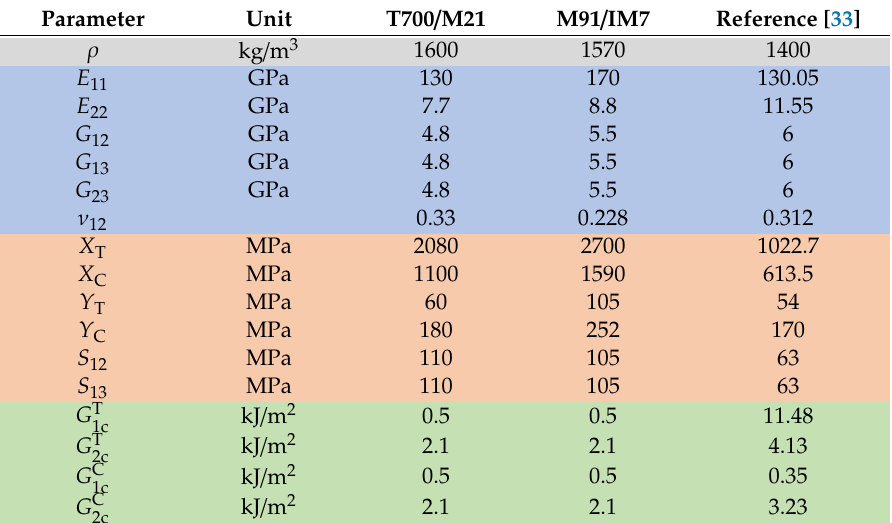
Table 1. Material properties of the considered